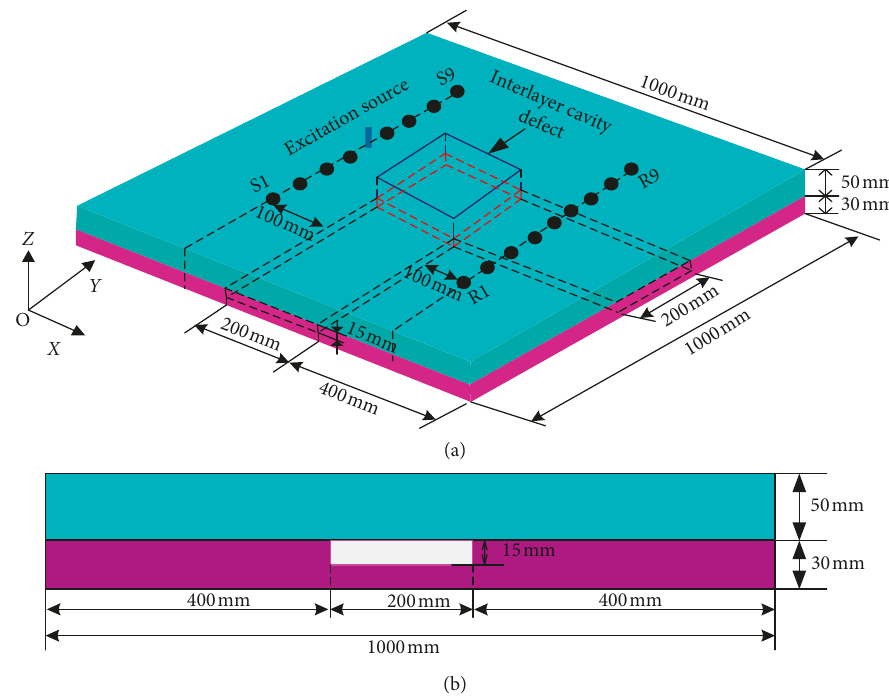
Figure 2: Schematic of the finite element model: (a) 3D finite element model; (b) sectional view.